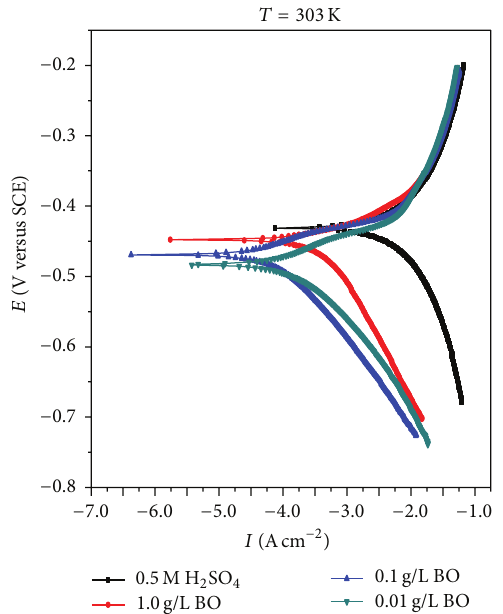
Figure 1: Potentiodynamic polarization curve for pipeline steel in 0.5 M sulfuric acid with different concentrations of Brassica oleracea extract at 303